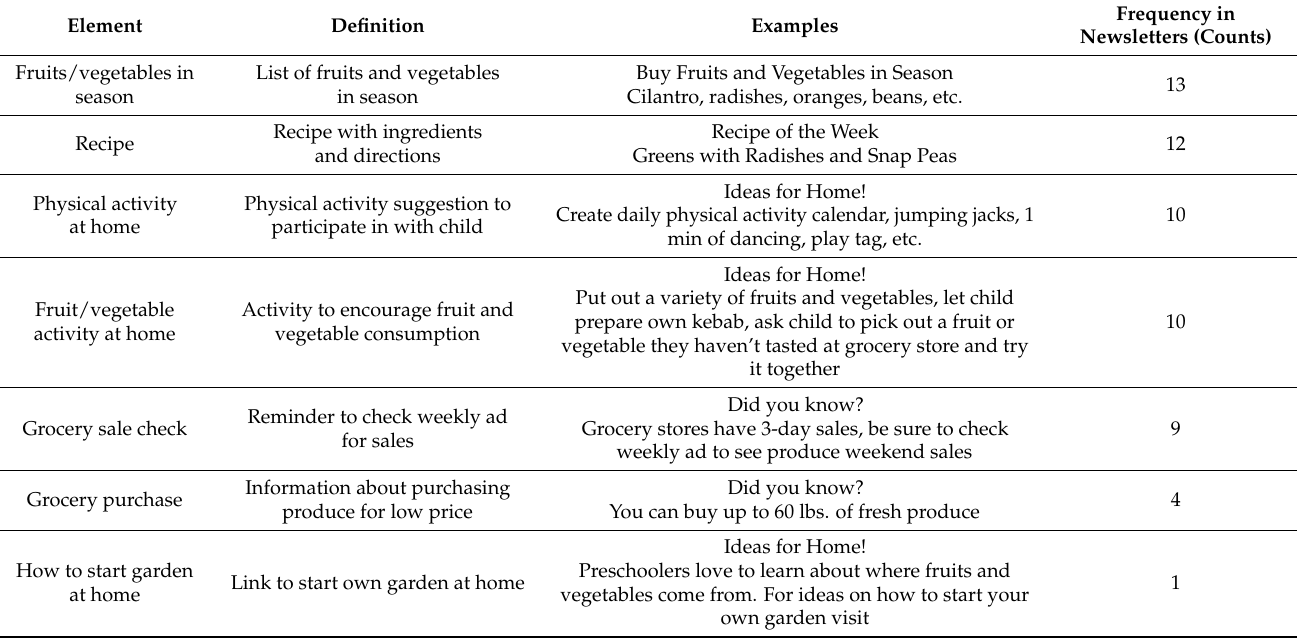
Table 3. Definitions, Examples, and Frequency of Newsletter